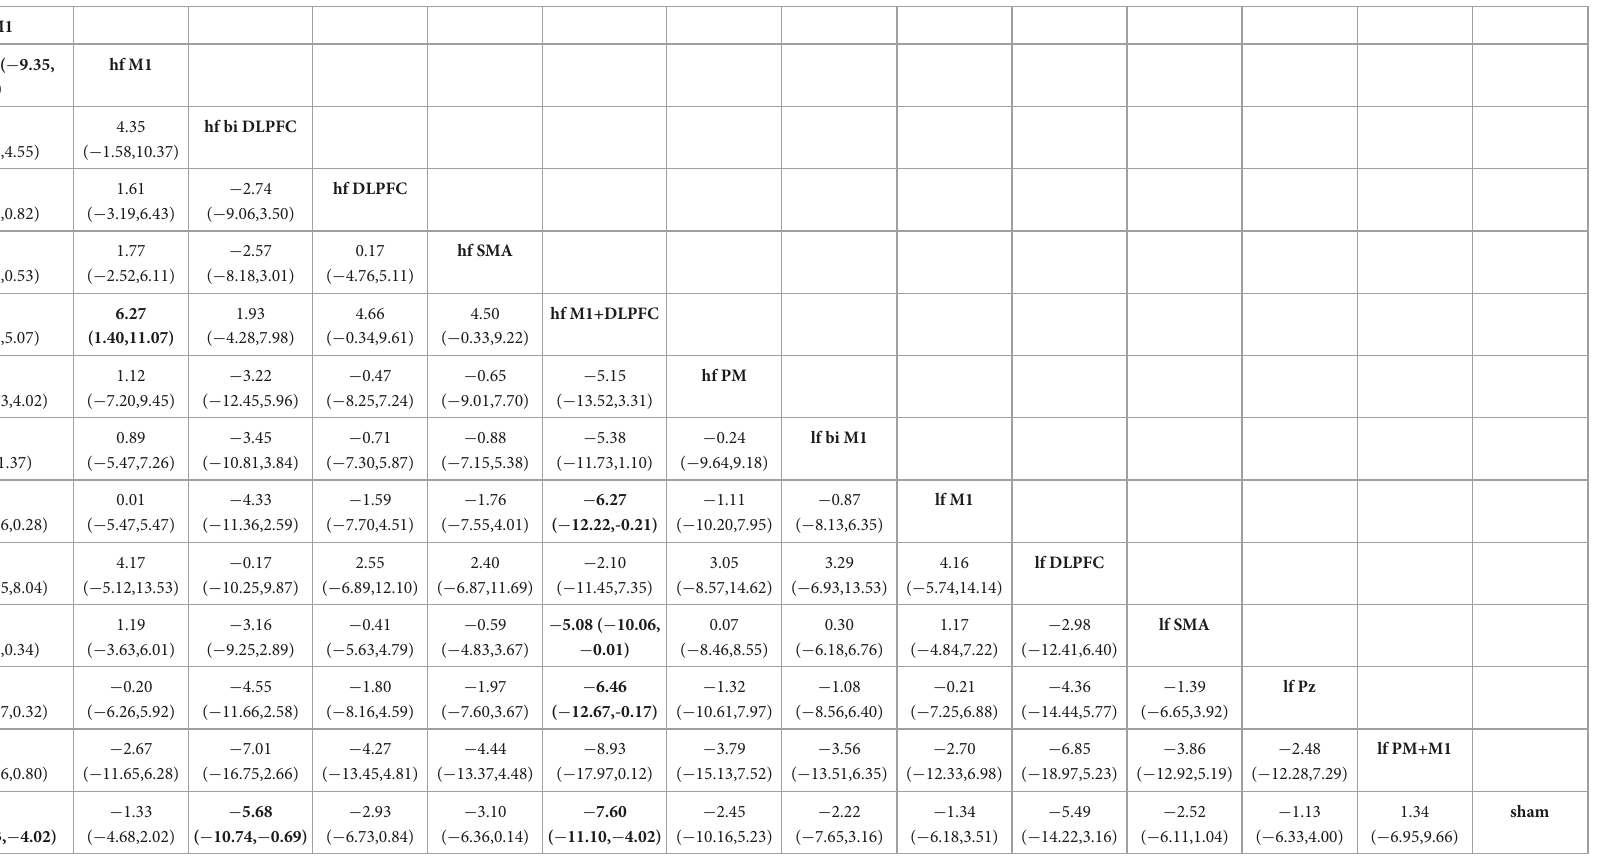
TABLE 2 The results of the network meta-analysis reported with mean difference (MD) and 95%